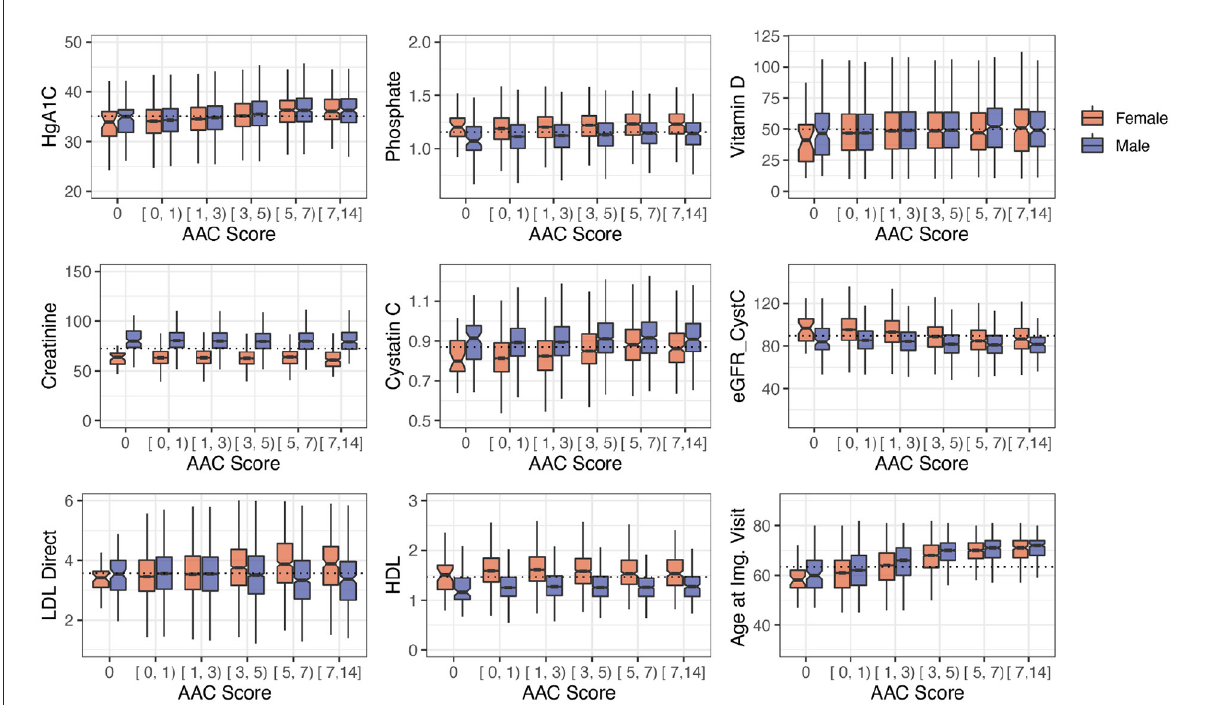
FIGURE8 Distribution plots for a selected set of biomarkers plotted as a function of calcification severity. Elevated HgA1c and phosphate were the strongest biochemical predictors of AAC identified in adjusted regression models. LDL and kidney biomarkers (Vitamin D, Creatinine, Cystatin C, eGFR are not statistically significantly associated with AAC after age adjustment (see Figure